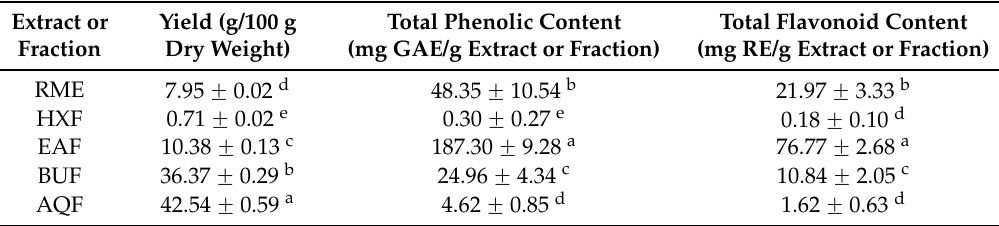
Table 1. Extract/fraction yield, total phenolic content and total flavonoid